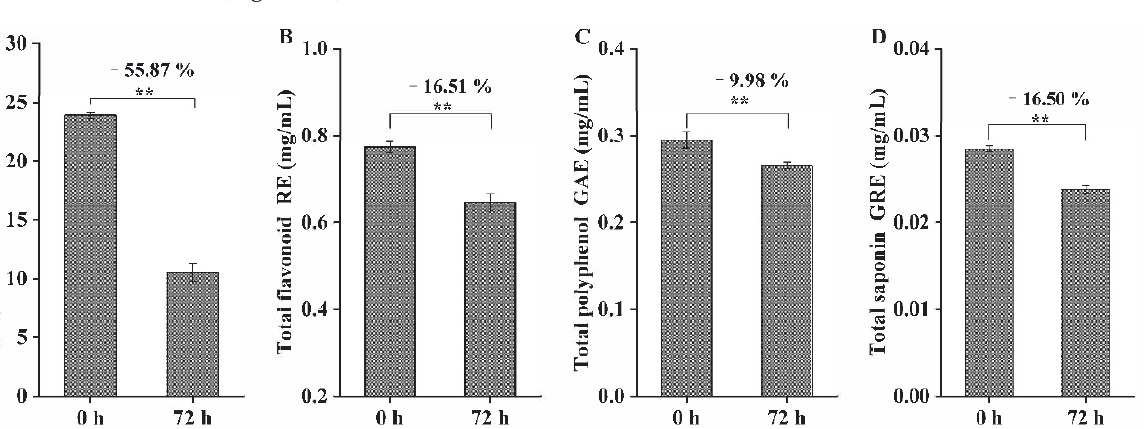
Figure 3. Changes in functional components in SHLE fermented by L. fermentum grx08 at 0 h and 72 h. ( A ) Total polysaccharide content (TPSC). Data are expressed as mg of glucose equivalent (GlcE) per mL of SHLE; ( B ) total flavonoid content (TFC). Data are expressed as milligrams of rutin equivalent (RE) per mL of SHLE; ( C ) total polyphenol content (TPC). Data are expressed as mg of gallic acid equivalent (GAE) per mL of SHLE; ( D ) total saponin content (TSC). Data are expressed as mg of ginsenoside Re equivalent (GRE) per mL of SHLE. Data are reported as the mean ± standard error of the mean (SEM). ** indicates that there was a significant difference between 0 h and 72 h ( p < 0.01).